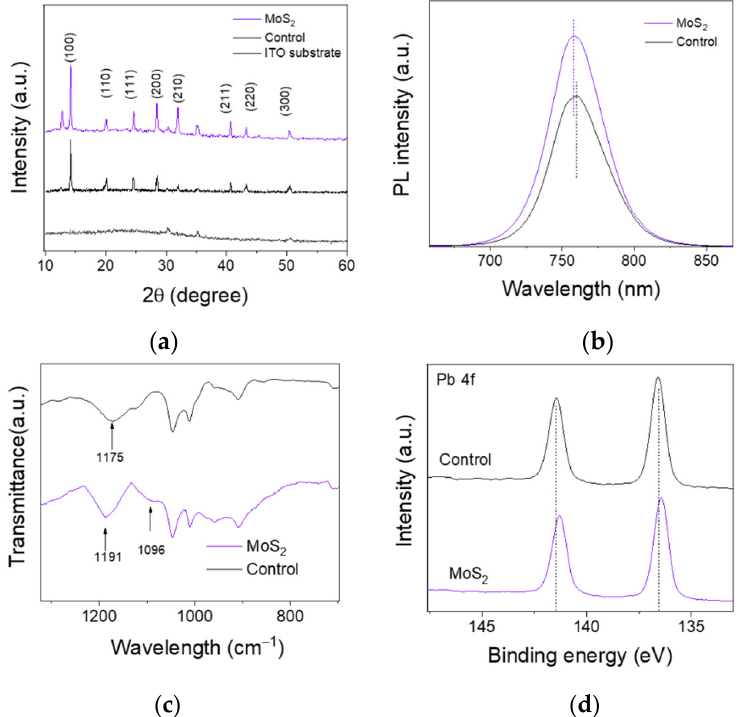
Figure 4. ( a ) XRD patterns, ( b ) PL spectra, and ( c ) FTIR spectra of perovskite film with and without MoS 2 . ( d ) High-resolution Pb 4 f peaks of the perovskite films with and without MoS 2 QDs.